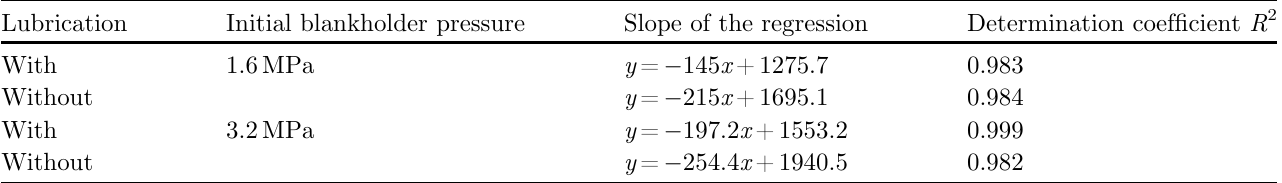
Table 11. Regression analysis of variation of the drawing radius in the case of using MMC tool with